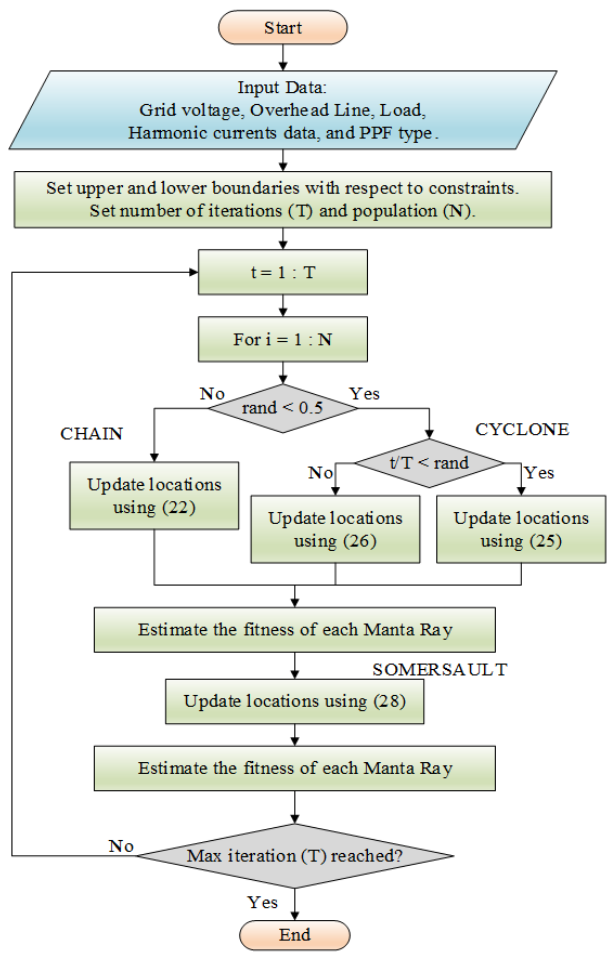
Figure 7. Flowchart of the PPF optimization problem using the MRFO algorithm.